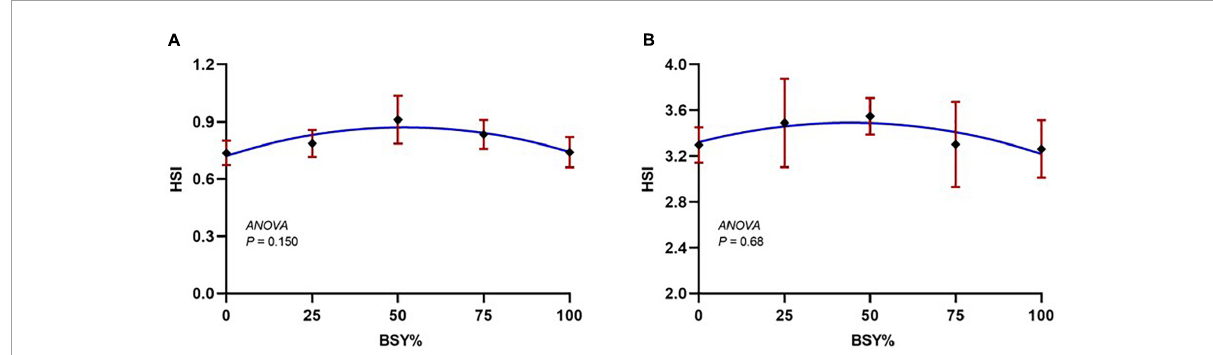
FIGURE3 The responses of organo-somatic indices of climbing perch fingerlings to the graded incorporation level of BSY in diet for 60 days. The X-axis represents the gradient inclusion levels of BSY in the place of fishmeal. (A) HSI, Hepatosomatic index and (B) VSI, Viscerosomatic index. The values are expressed as Mean ± SD, n =